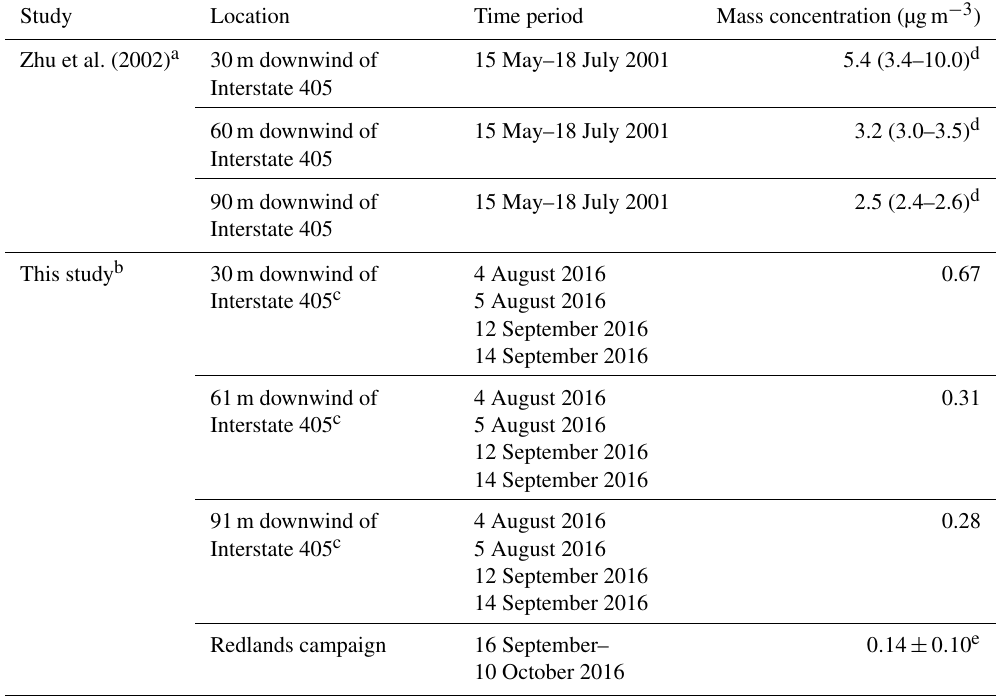
Table 2. Mean rBC mass concentration for the Redlands measurement campaign, and mean rBC (and black carbon) mass concentrations corresponding to three measured distances downwind of Interstate 405 in the Los Angeles National Cemetery in 2016 (rBC from the current study) and 2001 (BC from Zhu et al.,